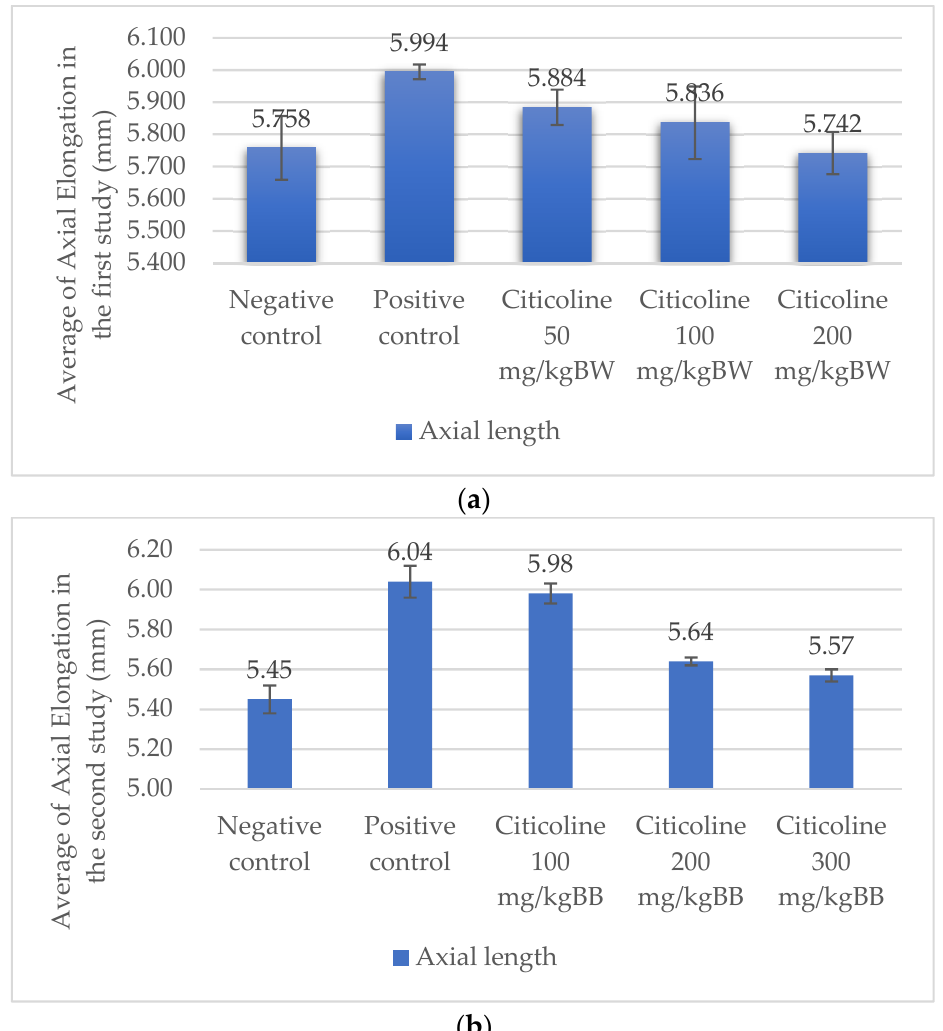
Figure 2. ( a ) A chart displaying the axial elongations in the first study. Based on Tukey test, the negative control (5.758 ± 0.099 vs. 5.994 ± 0.023, p = 0.001) and treatment group administered with the dose of 100 mg/kg BW (5.836 ± 0.113 vs. 5.994 ± 0.023 vs, p = 0.032) and 200 mg/kg BW (5.742 ± 0.066 vs. 5.994 ± 0.023, p = 0.000) show the most controlled axial elongation compared to positive control group. ( b ) A chart of the axial elongations in the second study. Based on Tukey test, the negative control (5.45 ± 0.07 vs. 6.04 ± 0.08, p = 0.000) and the treatment groups with a dose of 200 mg/kg BW (5.64 ± 0.02 vs. 6.04 ± 0.08, p = 0.000) and a dose of 300 mg/BW (5.57 ± 0.03 vs. 6.04 ± 0.08, p = 0.000) show the most controlled axial elongation compared to positive control